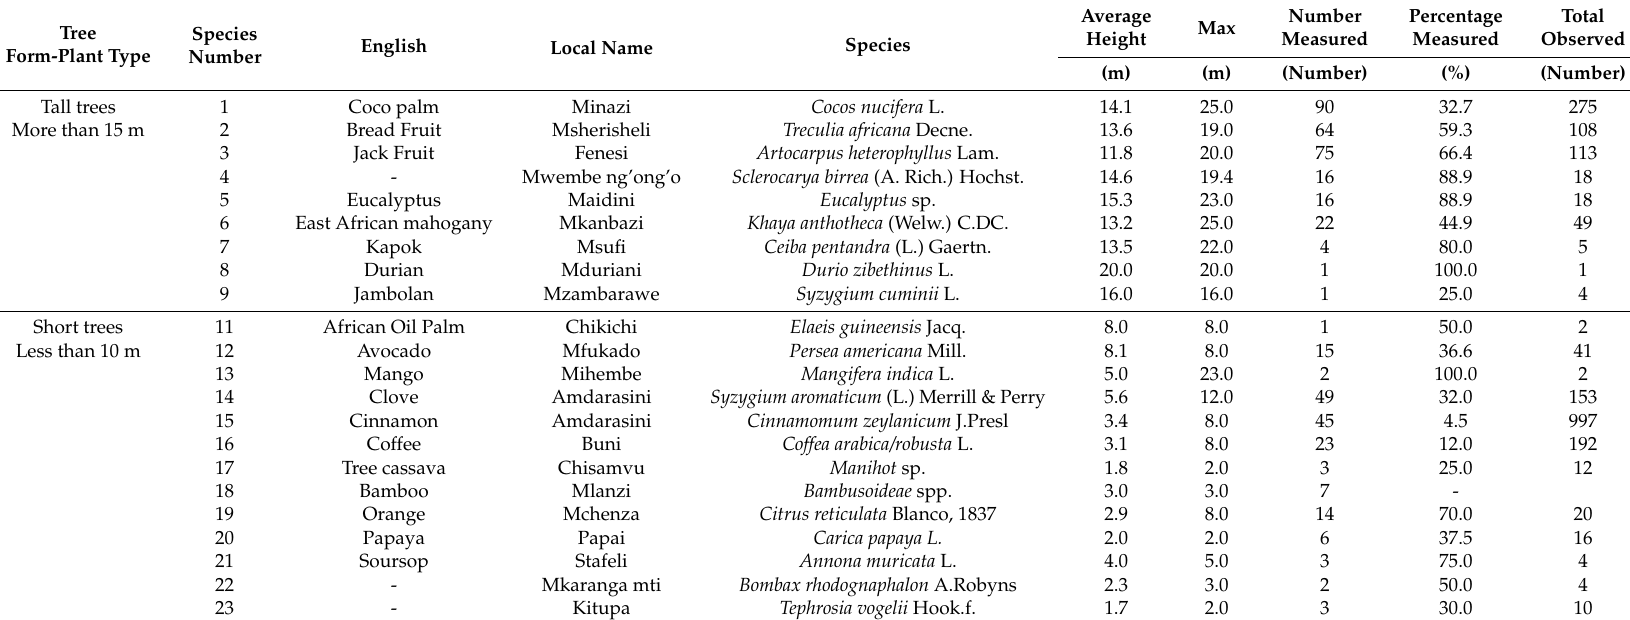
Table 2. Classification of the 23 tree crops observed in the homegardens of the 43 households according to their height. Tree Form-Plant